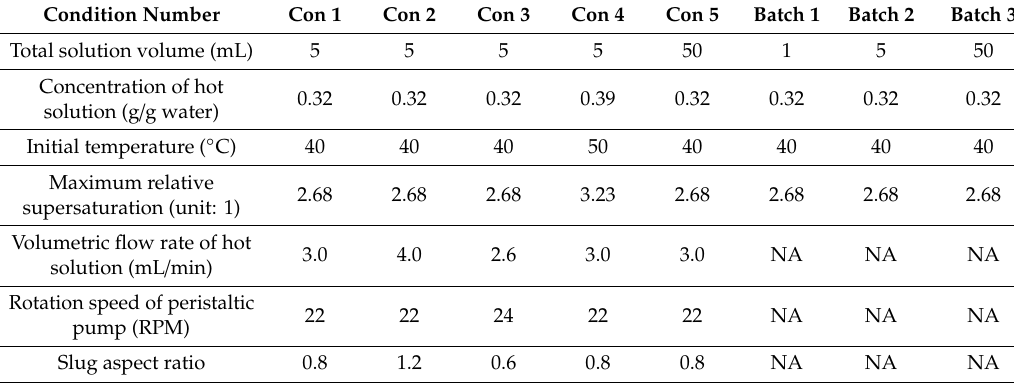
Table 1. Experimental conditions for cooling crystallization in slug flow and batches. Conditions 1–5 (denoted as Con 1–5) are in slug flow. Conditions 1–3 are at 3 di ff erent slug aspect ratios, with all other conditions the same, and no secondary nucleation. Conditions 1 and 4 are at di ff erent starting concentration and temperatures, with all other conditions the same (including the slug aspect ratio of 0.8). Condition 5 is a scale-up experiment of Condition 1. Batches 1–3 are the batch crystallization of di ff erent total volume. The maximum supersaturation is based on the starting concentration in Table 1 and the solubility profile in Figure S1. The slug aspect ratio is defined as the ratio between slug length along with the tubing to tubing inner